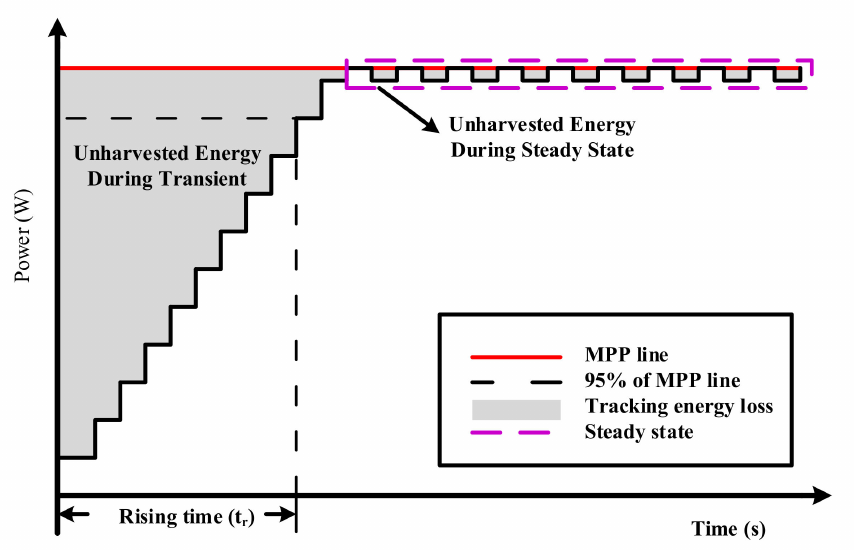
Figure 6. Tracking response of the MPPT